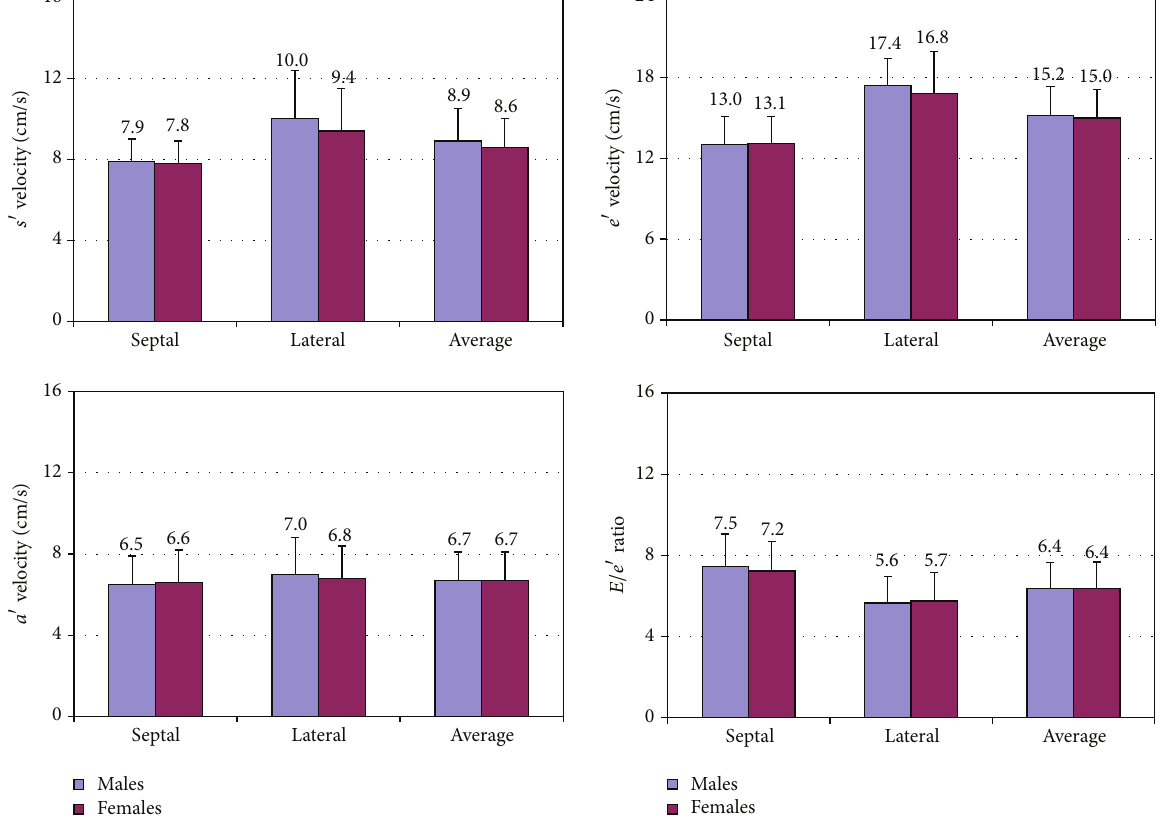
Figure 1: Comparison of left ventricular (LV) longitudinal indexes between male and female subjects in the study population. 𝑎 󸀠 is peak late diastolic LV longitudinal velocity; 𝑒 󸀠 is peak early diastolic LV longitudinal velocity; 𝐸 is peak early diastolic left ventricular filling velocity; 𝑠 󸀠 is peak systolic LV longitudinal